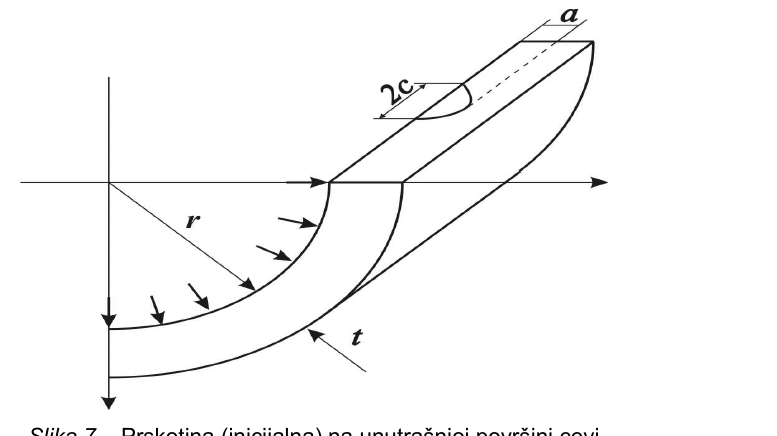
Figure 7 – Crack (initial) on the inner surface of the tube